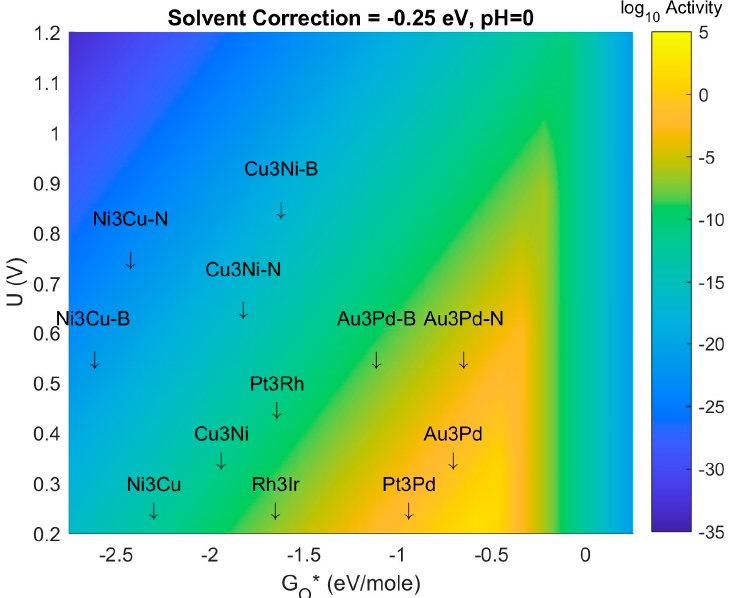
Figure 10. Volcano Plot analysis for ORR activity at pH = 0. Top left (Solvent correction = − 0.35 eV), Top right (Solvent correction = − 0.45 eV), Bottom left (Solvent correction = − 0.20 eV), Bottom Right (Solvent correction = − 0.00 eV). All plots at pH = 0. Blue denotes lowest activity, yellow denotes highest activity. All plots use same color-axis scale hence some saturation at maximum activity and minimum activity. Activity given in log10 scale to show more detail in plot.